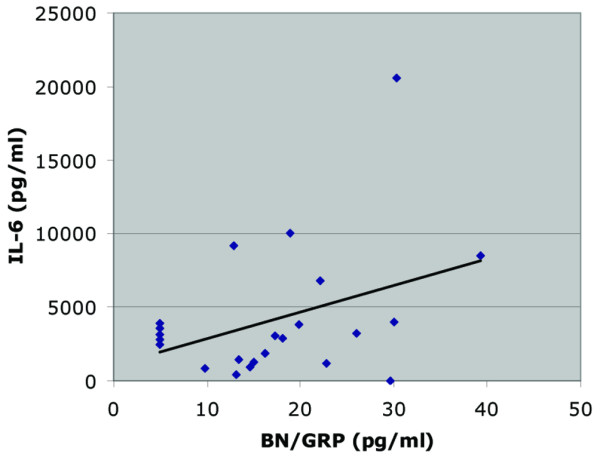
Scatter plot, with linear regression line, showing correlation between BN/GRP and IL-6 in synovial fluid. Spearman's rank correlation coefficient (rs = 0.38; P < 0.05) measured, using RIA and ELISA, in synovial fluid from patients with long-standing RA. BN/GRP, bombesin/gastrin-releasing peptide; RA, rheumatoid arthritis.